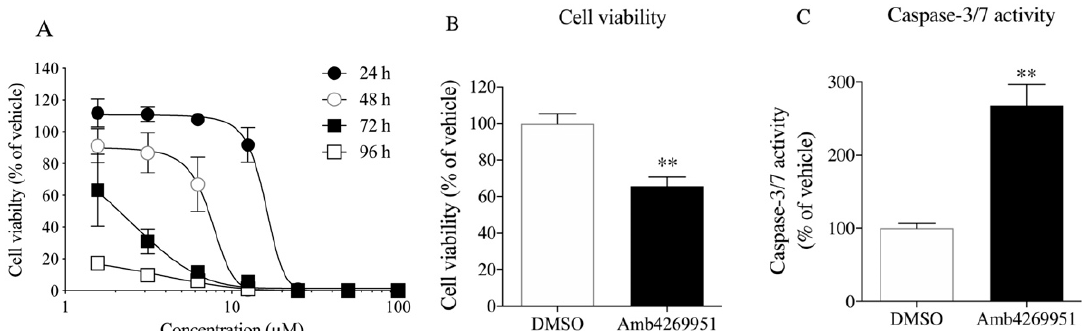
Figure 3. Effects of Amb4269951 on cell viability and caspase-3/7 activity in U251MG cells. ( A ) Cells were pre-incubated with various concentrations of Amb4269951 for 24, 48, 72, and 96 h, and then the cells were counted. The results are given as a percentage of the findings in the vehicle control. Each point represents the mean ± SD ( n = 3). The effects of 6.25 µM Amb4269951 on cell viability ( B ) and caspase-3/7 activity ( C ) in U251MG cells. The cells were pre-incubated with 6.25 µM Amb4269951 for 24 h, and then the cell number and caspase-3/7 activity were measured. The results are given as a percentage of the findings in the vehicle control (DMSO). Each column represents the mean ± SD ( n = 4). ** p < 0.01 compared to the vehicle control (DMSO).